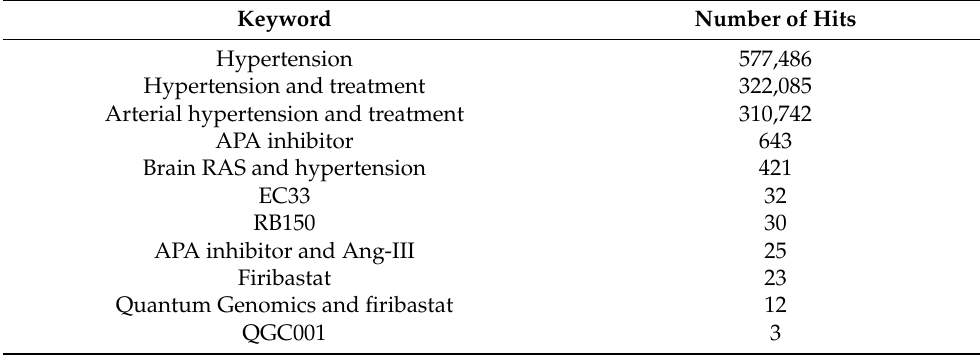
Table 3. Search terms and number of hits